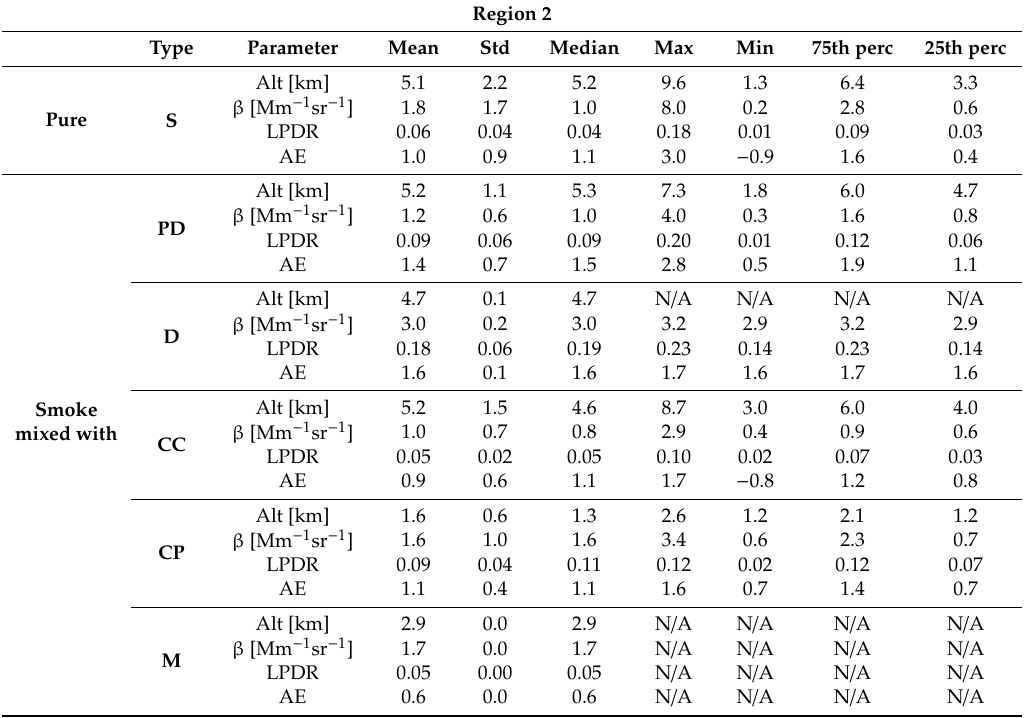
Table A2. Descriptive Statistics for di ff erent aerosol types for Region 2 (R2): mean, standard deviation (std), median, maximum value (max), minimum value (min), 75th and 25th percentile for all variables. Region 2 Type Parameter Mean Std